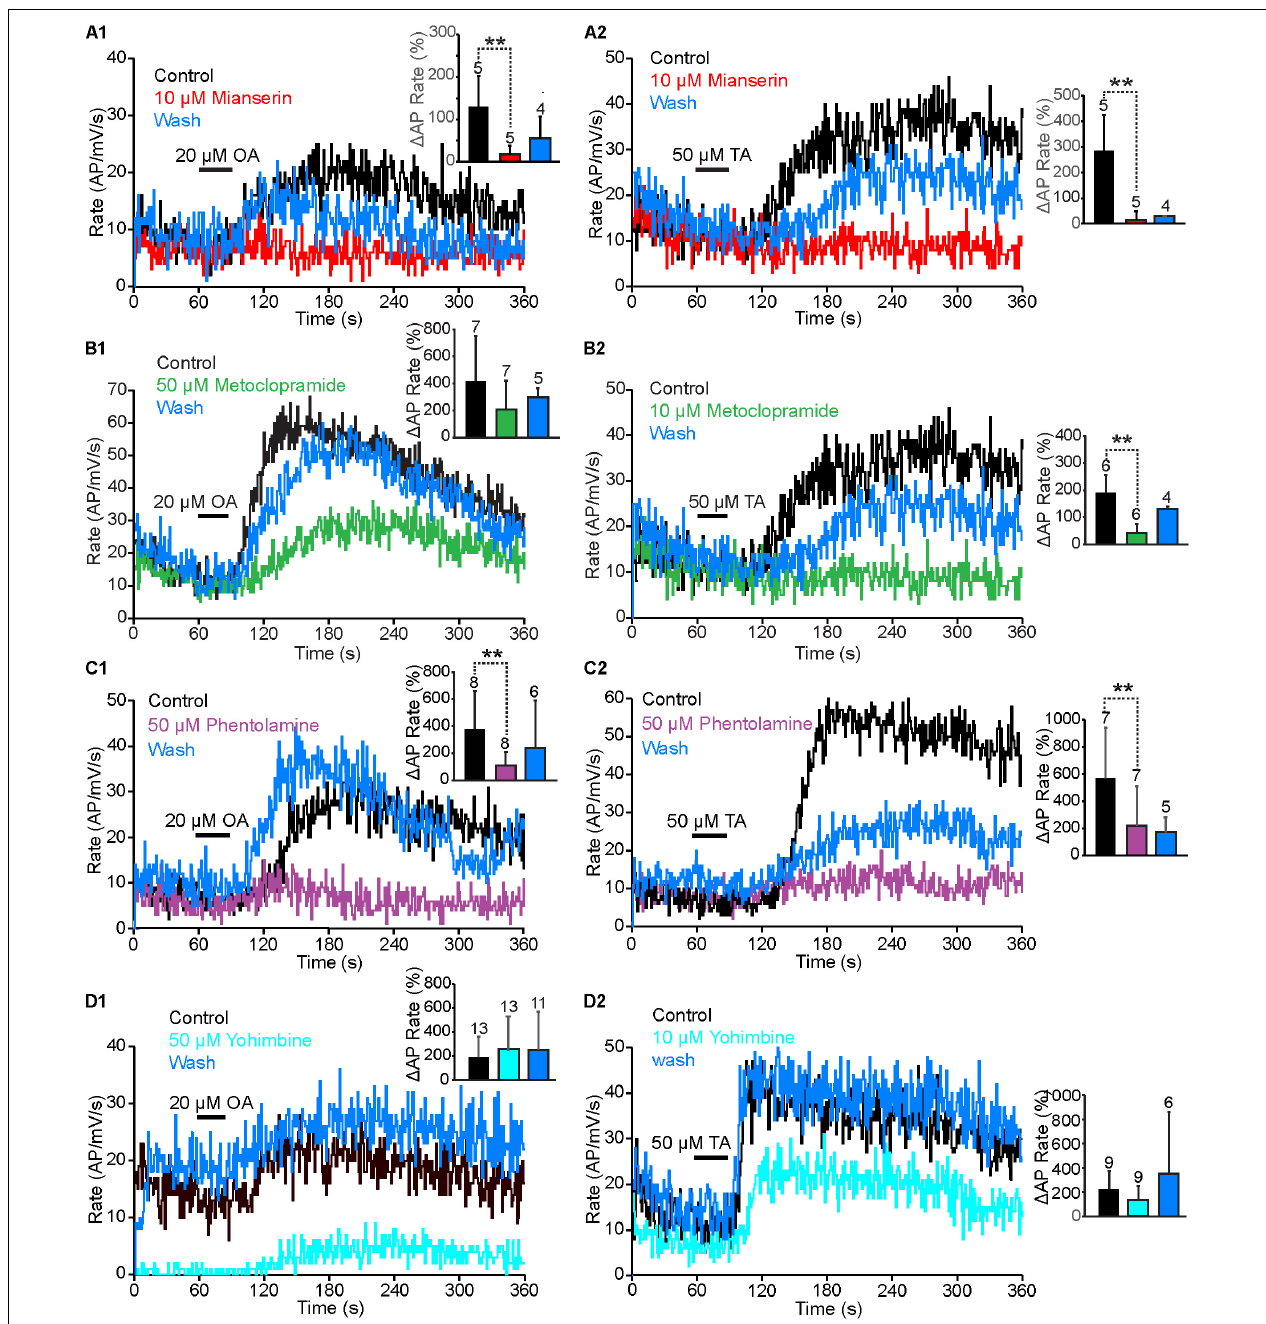
FIGURE 5 | Antagonist effects on OA and TA responses. (A1,A2) The rise in OA or TA induced AP rate was smaller when mianserin was added into the superfusion than under control conditions. This effect was reversed partially after wash. (A1,A2) OA and TA induced changes in spike rate in mianserin treated neurons were statistically significantly smaller than under control conditions. (Paired t -tests. OA: p = 0.005495, t = 4.48, df = 4. TA: p = 0.0035905, t = 5.06, df = 4). ( B1,B2) Increases of AP rates by OA and TA were larger under control conditions, than with metoclopramide in the superfusion. These effects recovered almost completely after wash. (B1,B2) The OA induced changes to AP rate by metoclopramide were not statistically significant (Paired t -test p = 0.0959795, t = 1.47, df = 6), but the TA induced change was statistically significant (Paired t -test, p = 0.003895, t = 4.29, df = 5). ( C1,C2) Phentolamine strongly inhibited the VS-3 neurons response to OA and TA and this effect was at last partially reversible. (C1,C2) Phentolamine effects were statistically significant. (OA: paired t -test t = 4.03, df = 7, p = 0.002498. TA: Wilcoxon rank-sum test W = 28, n s / r = 7, p = 0.01). (D1) Fifty micromolar yohimbine in the superfusion clearly reduced the neuron’s response to pseudorandom noise stimulus, but it still responded to OA with an increase in AP rate. After wash, the neuron responded to the same stimulus with higher spike rate than control and the response was amplified by OA application. (D2) Ten micromolar yohimbine also reduced the baseline spike rate, but TA application amplified it and the neuron was more easily excitable after wash. (D1,D2) Yohimbine effects on the OA or TA effects were not statistically significant (Wilcoxon signed-ranks test for OA W = 11, n s / r = 13, z = 0.37, p = 03557 and for TA W = 23, n s / r = 9). Numbers of experiments are indicated above each bar.